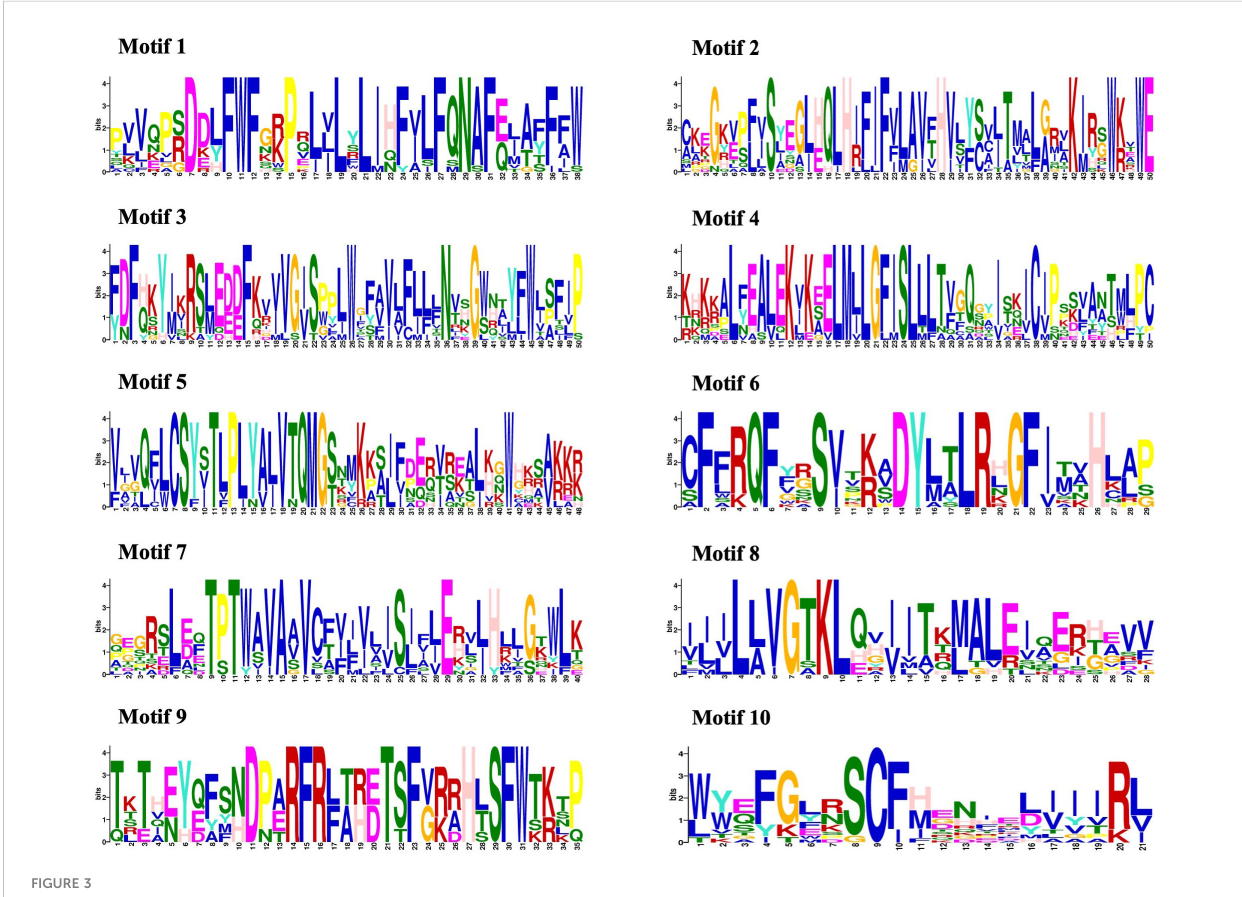
FIGURE 3 Conserved motif analysis of the CmMLO